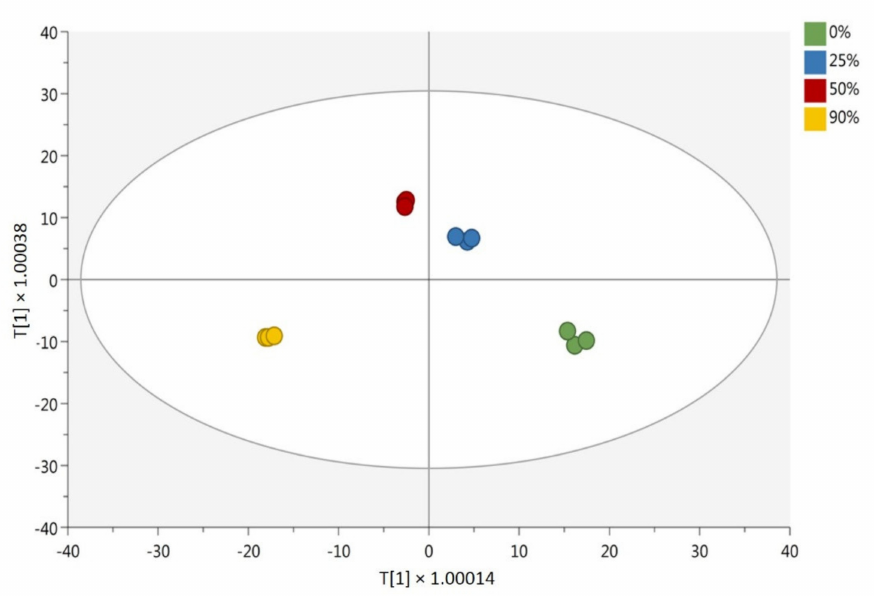
Figure 5. Orthogonal projection to latent structures discriminant analysis (OPLS-DA) on different concentrations of hydroalcoholic phyto-extracts of Artemisia annua , i.e., AA ethanol 0%, AA ethanol 25%, AA ethanol 50%, and AA ethanol 90%. The parameters: goodness of fit R 2 Y: 0.997; goodness of prediction Q 2 Y: 0.898; cross-validation ANOVA p <